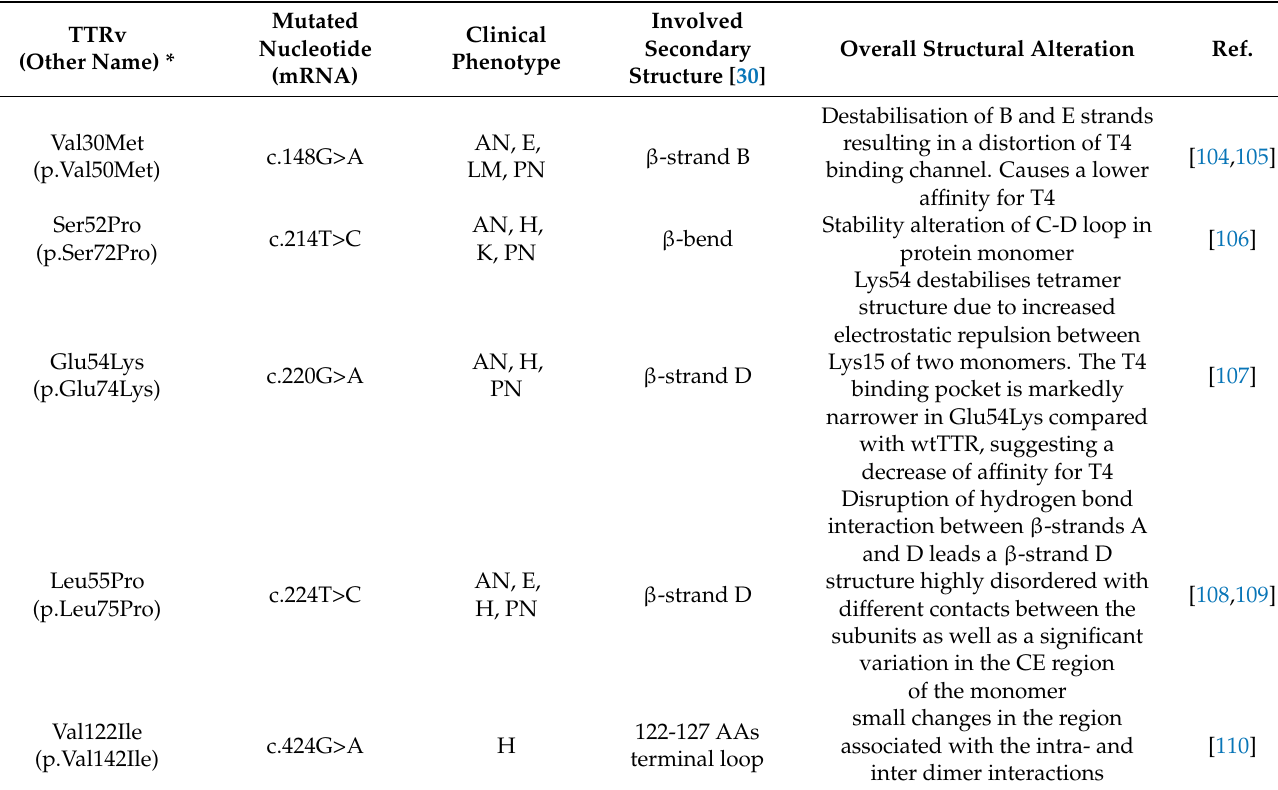
Table 1. Main TTR gene mutations and related structural